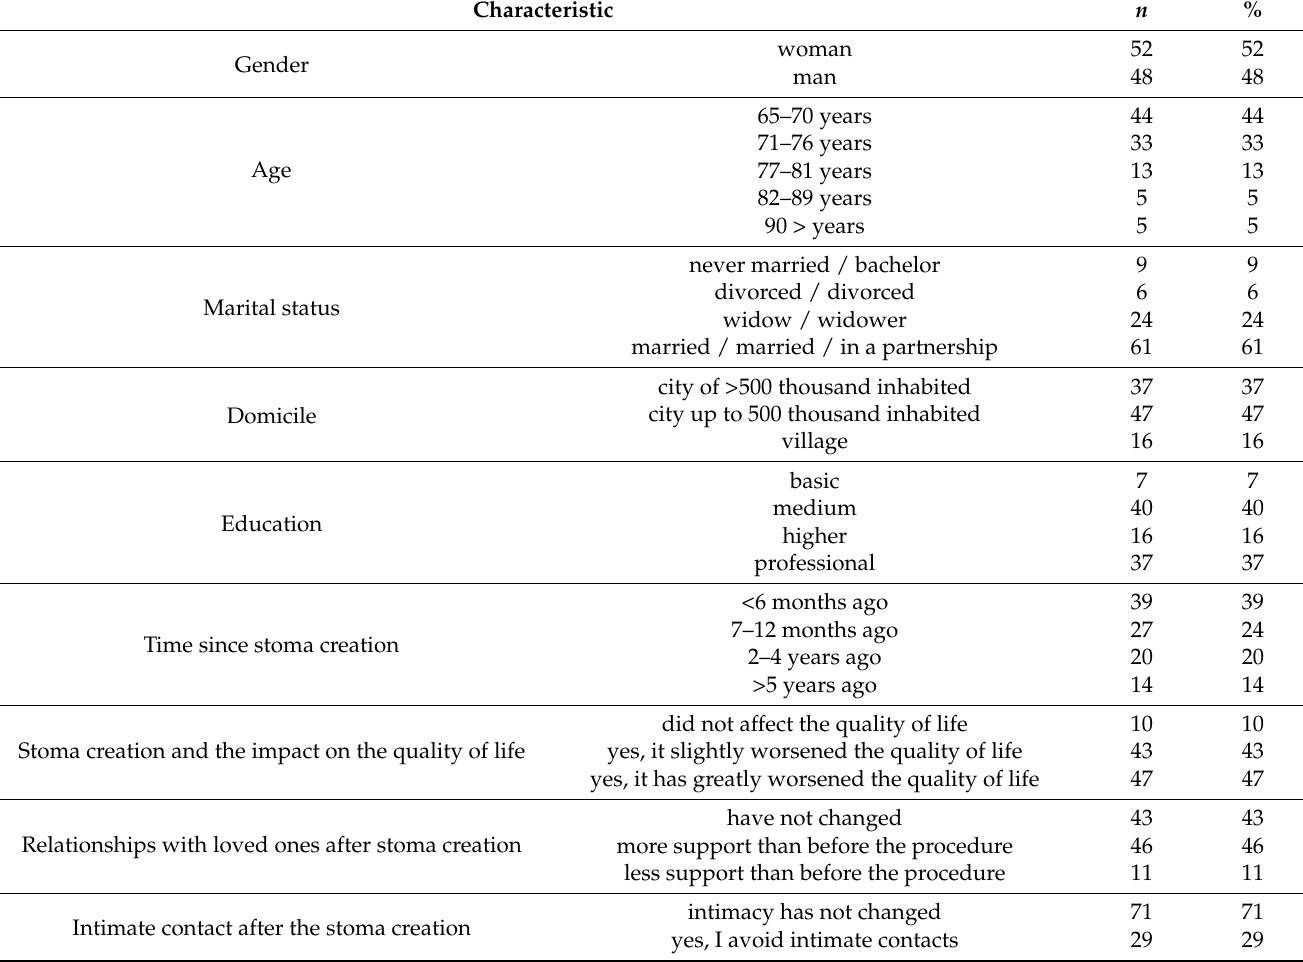
Table 1. Characteristics of the studied group.